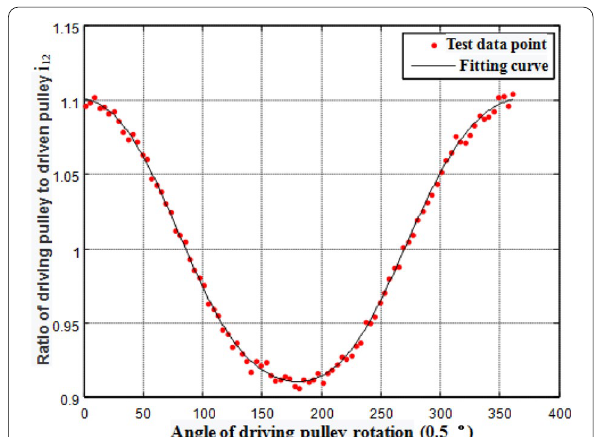
Figure 17 Simulation results of master–slave transmission ratio